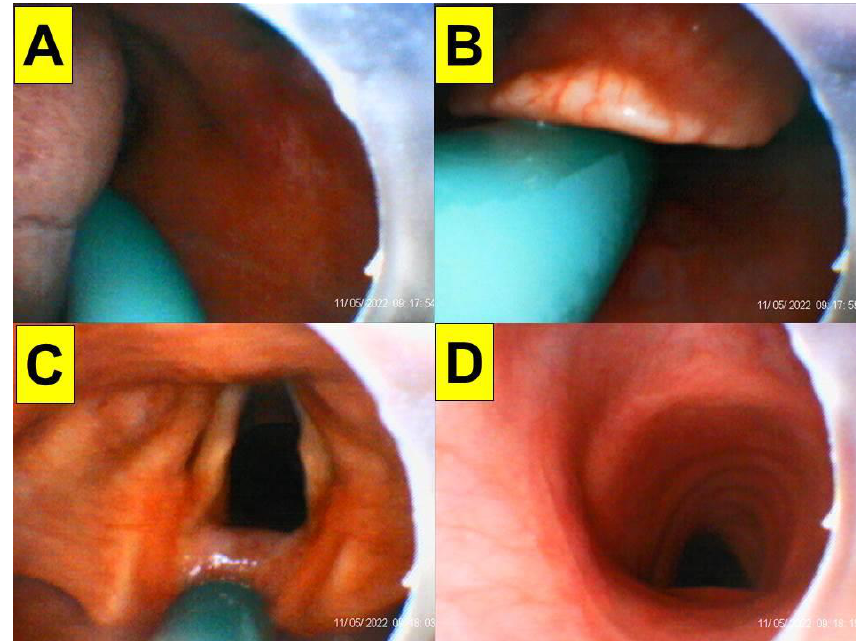
Figure 7. (Case 3) Close-up views during the endotracheal intubation using the video-assisted intu- bating stylet technique. ( A ) Oral space, ( B ) epiglottis, ( C ) full glottic visualization, ( D ) entry into